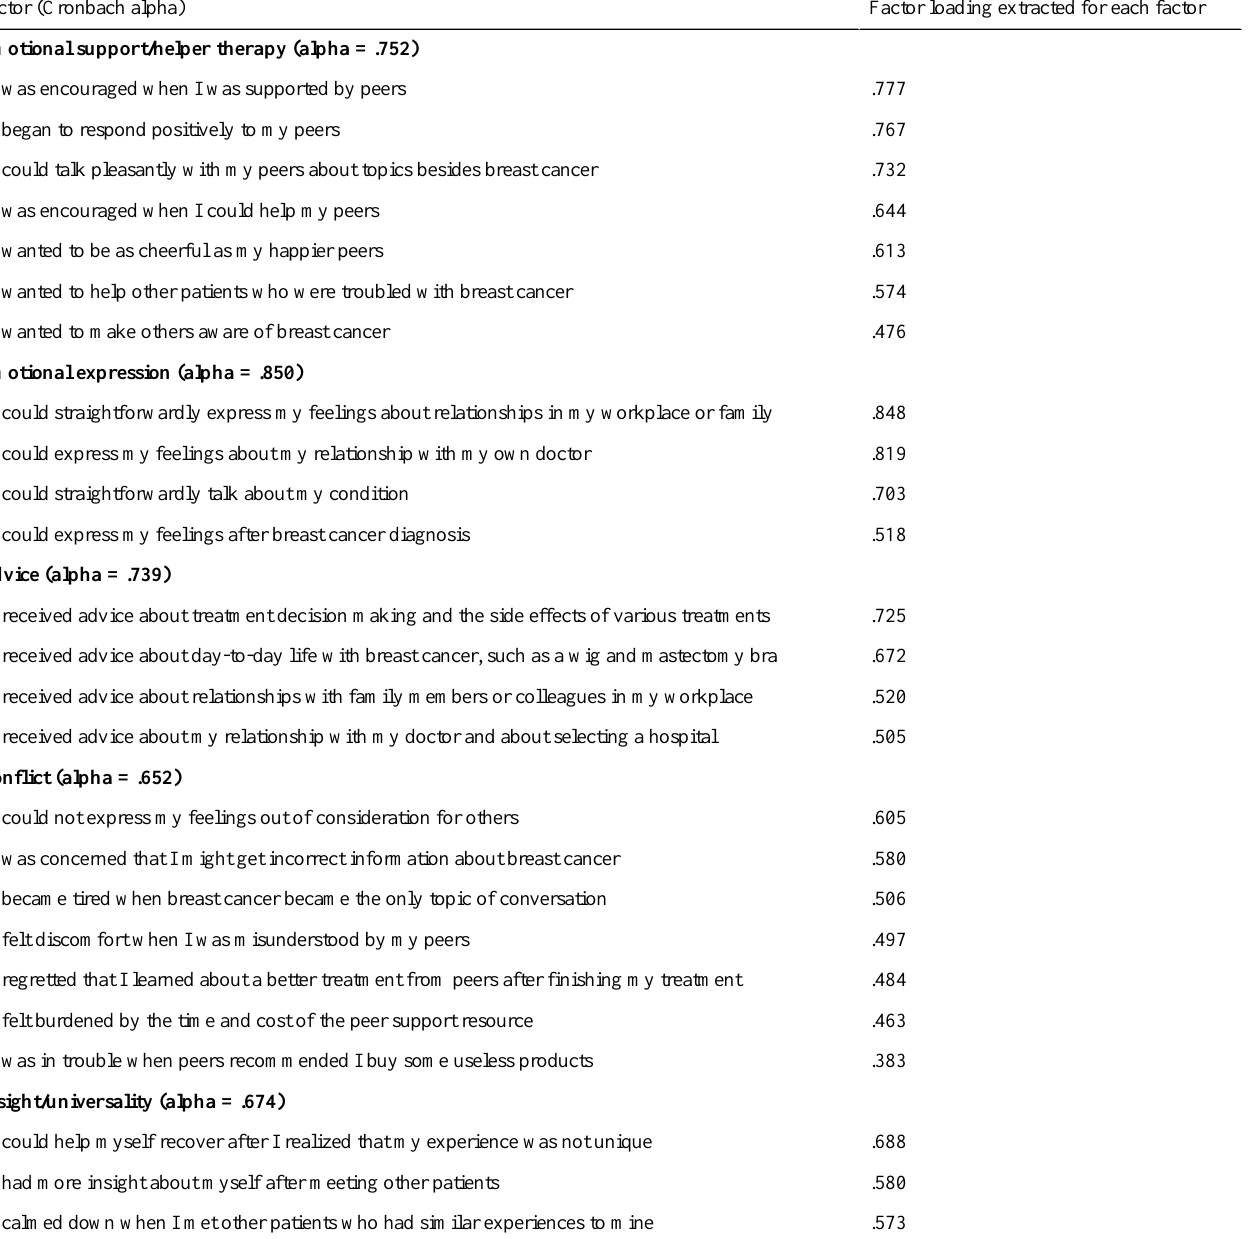
Factor loading extracted for each factorFactor (Cronbach alpha)